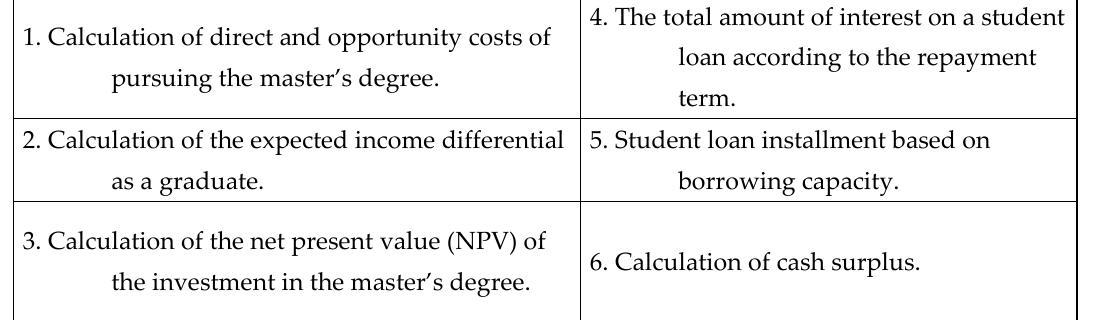
Figure 1. Objective financial knowledge measurement in the experiment. Source: author’s elaboration.